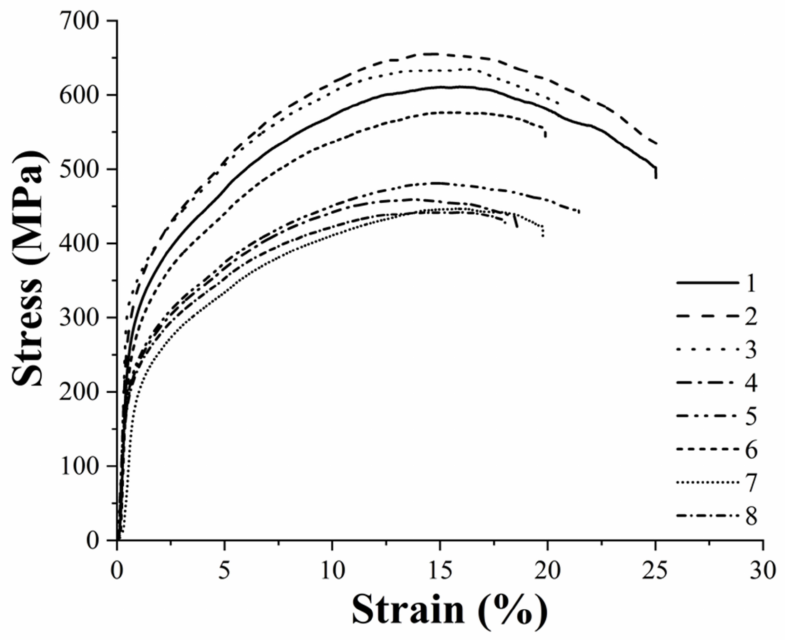
Figure 9. Typical bending curves of the eight printing configurations under consideration (the numbers in the legend stand for the number of printing profiles investigated, as numbered in Table